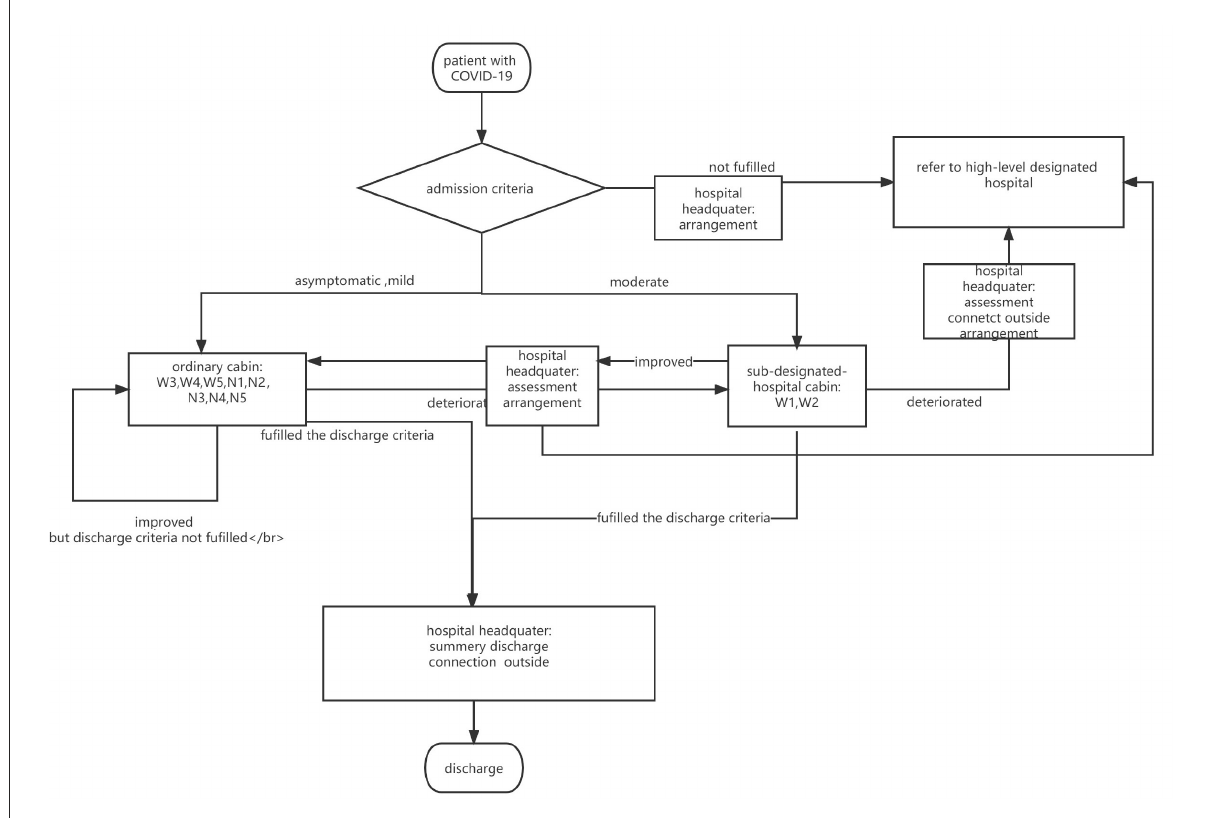
FIGURE3 Procedure of patient screening and infow in the SNIEC makeshift